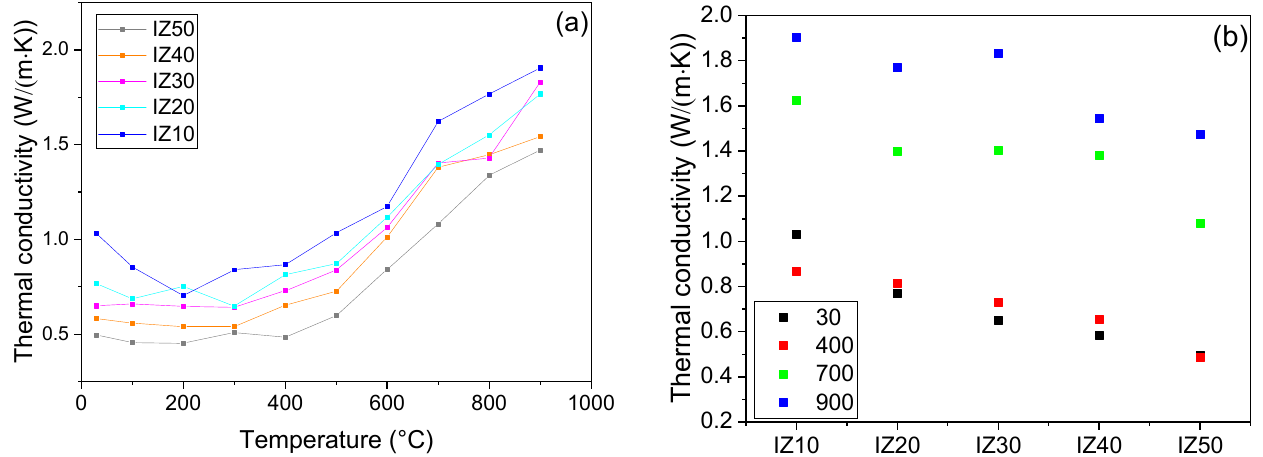
Figure 10. Thermal conductivity of the mixtures ( a ). Comparison of thermal conductivities at different temperatures ( b ).